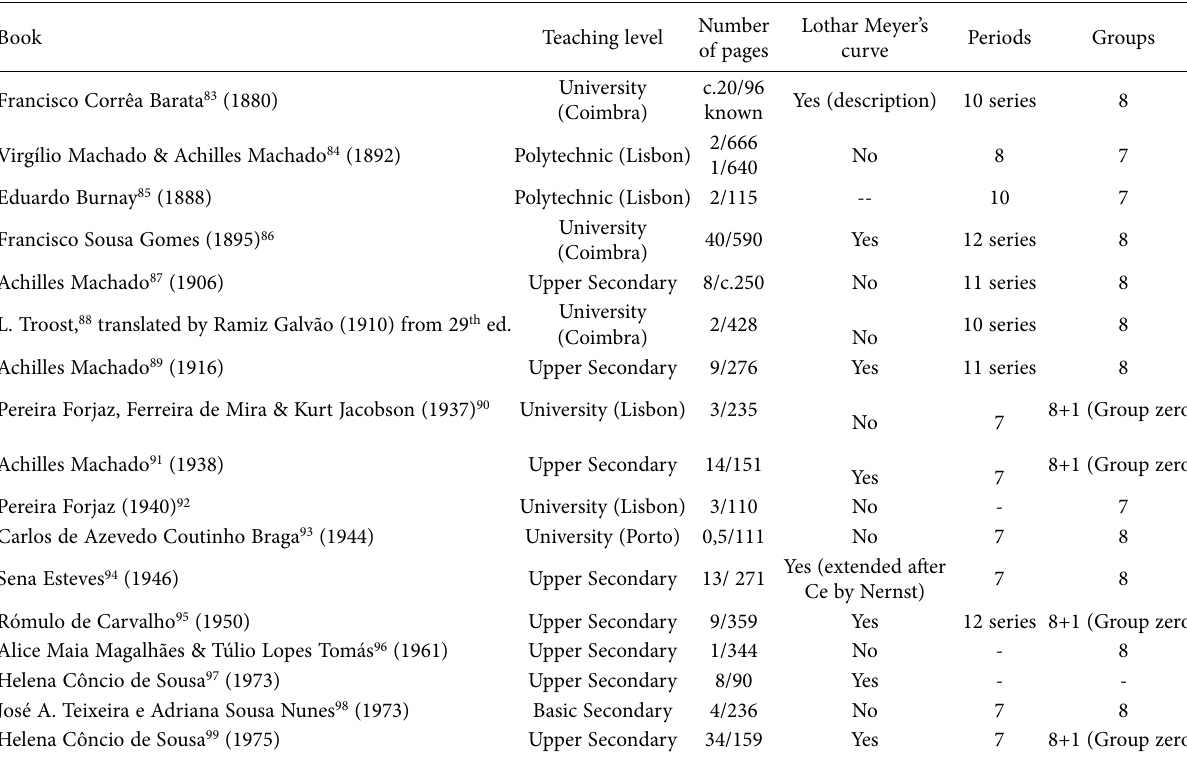
Table 4. Mentions of Mendeleev’s classification in the Portuguese textbooks analysed from 1880 (first mention found) to